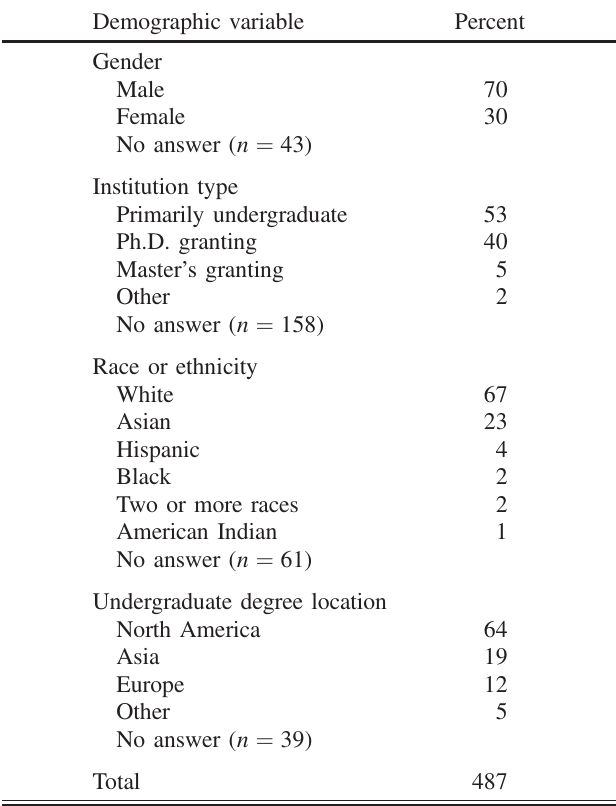
TABLE I. Demographics of the NFW survey